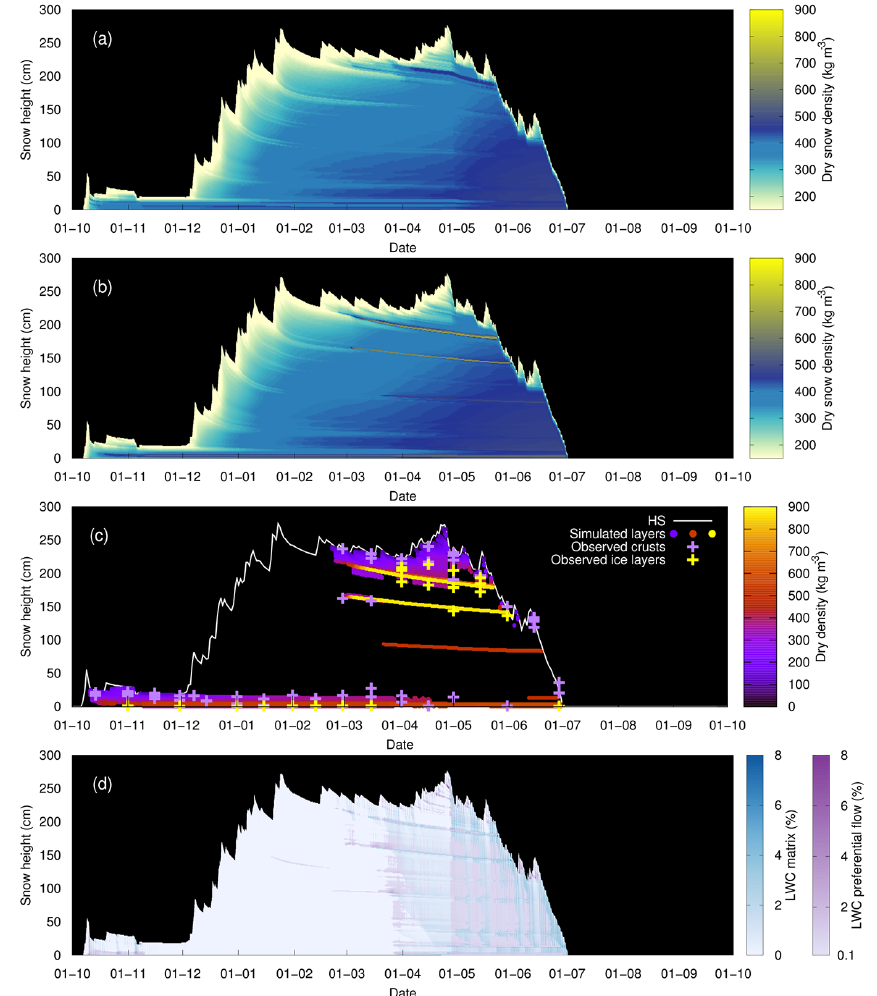
Figure 5. Dry snow density without considering preferential flow (a) and with preferential flow using high-resolution simulations (b) , validation with field observations (c) and liquid water content in the matrix and preferential flow domain for the simulation with preferential flow (d) , for snow season 2012. In (c) , modelled layers are shown when they are either a melt–freeze crust or have a dry snow